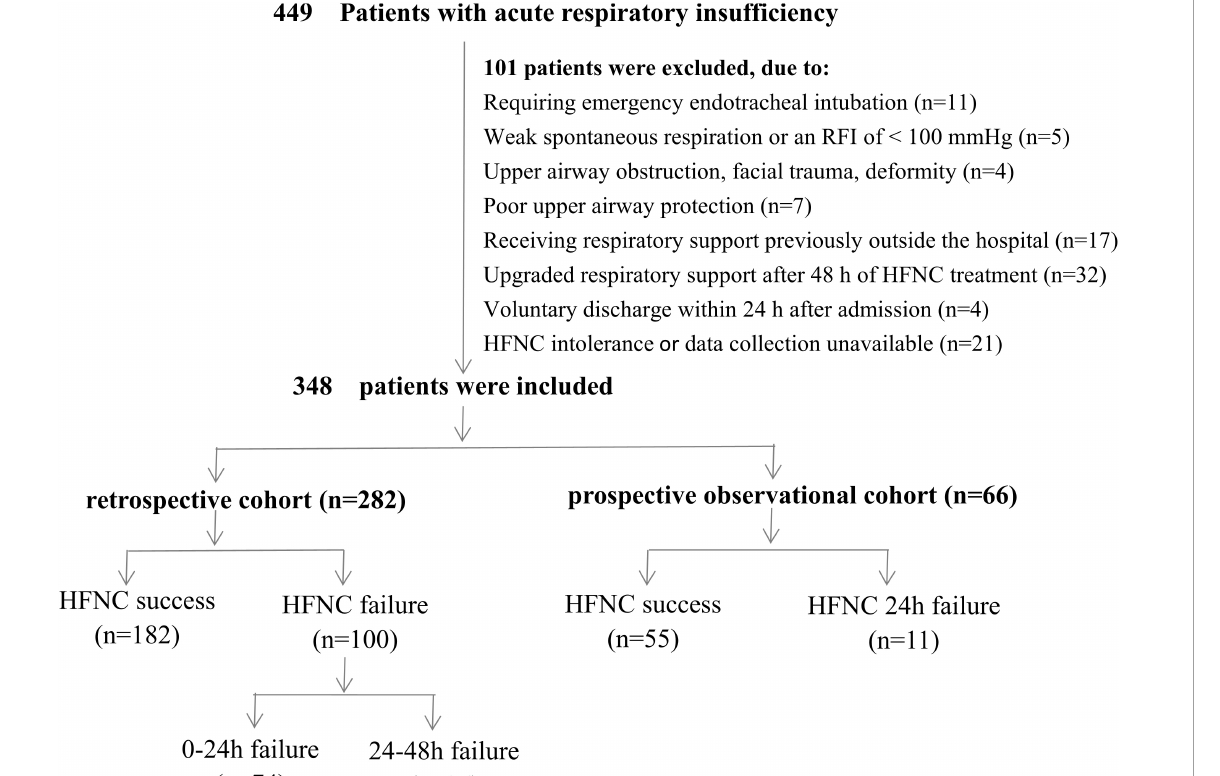
FIGURE1 Flow chart of the study. HFNC, high-flow nasal cannula.